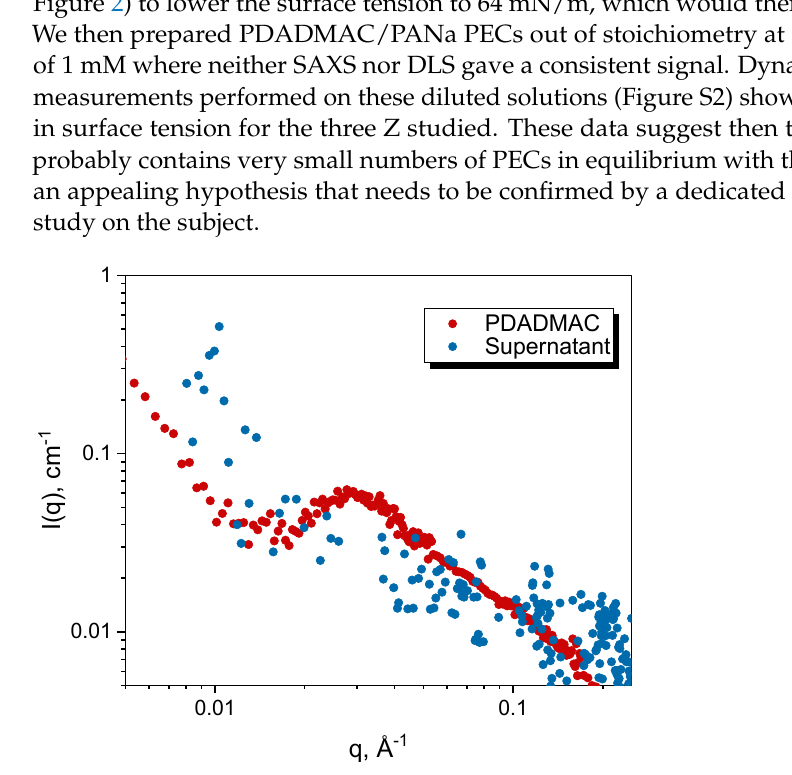
Figure 7. SAXS analysis of the supernatant phase of the PDADMAC/PANa system prepared at Z = 1 from 18.6 mM PE solutions. The signature of a 18.6 mM PDADMAC solution is also shown for comparison. We also note the presence of a polyelectrolyte peak (q~0.28 Å − 1 ) expected for this type of charged macromolecule.